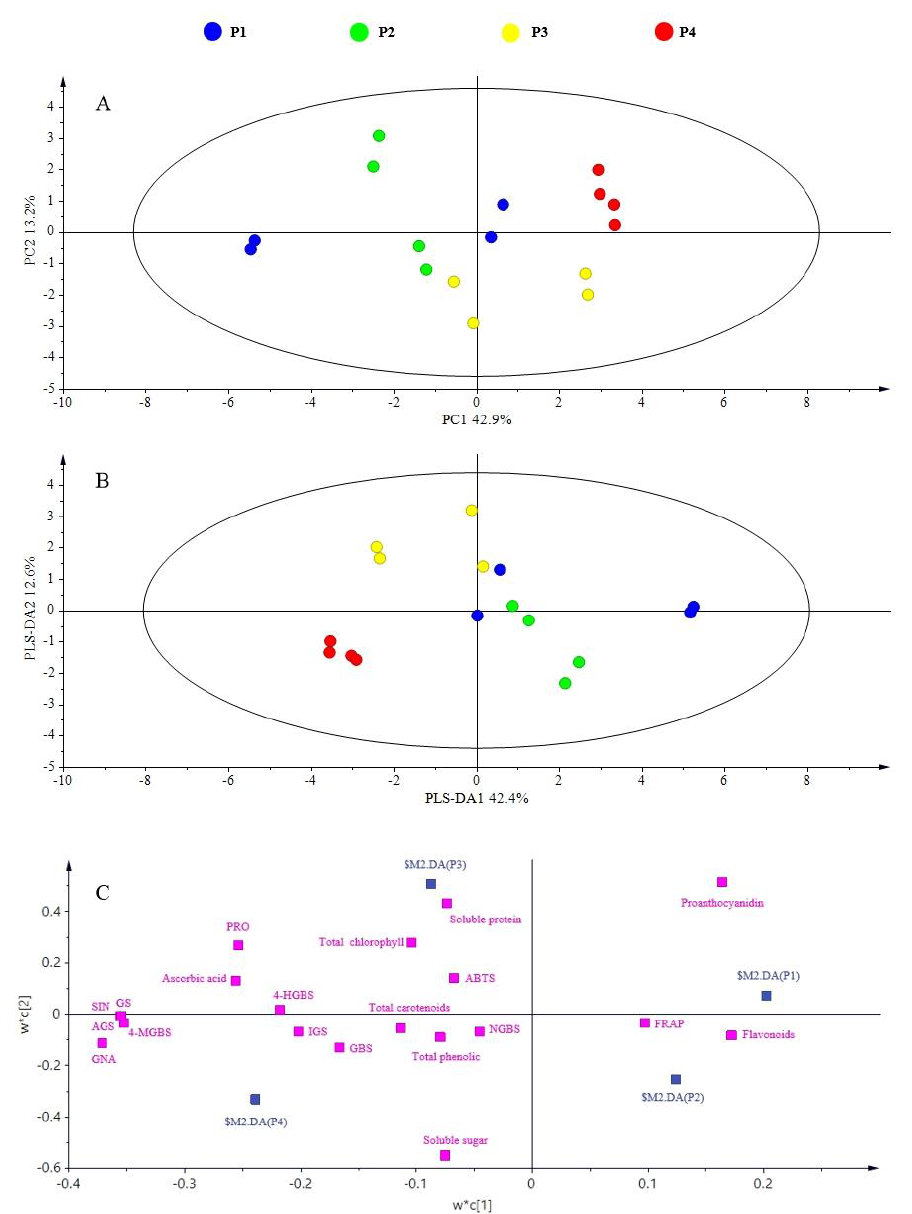
Figure 4. PCA analysis of different planting densities on mustard sprouts. ( A ) PCA score plot; ( B ) PLS- DA score plot; ( C ) loading plot. SIN: sinigrin; GNA: gluconapin; PRO: progoitrin; NGBS: neogluco- brassicin; GBS: glucobrassicin; 4-MGBS: 4-methoxyglucobrassicin; 4-HGBS: 4-hydroxyglucobrassicin; AGS: total aliphatic glucosinolates; IGS: total indolic glucosinolates; GS: total glucosinolates. P1: